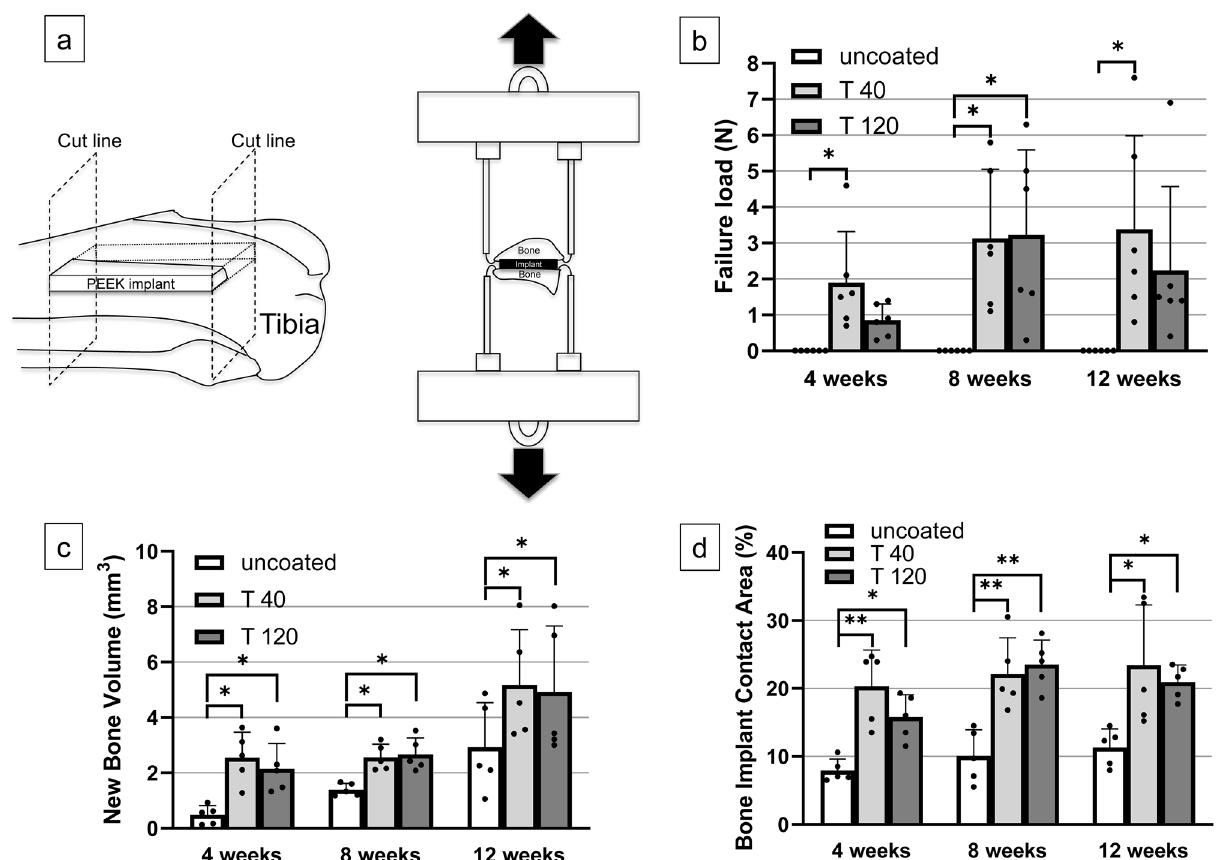
Figure 2. Results of the in vivo analyses of the rabbit tibia: ( a ) scheme of the detaching test measurements. The PEEK plates were implanted into the rabbit tibia and the bone-implant bonding strength was measured after harvesting; ( b ) failure load results for each study period; ( c ) new bone formation volume surrounding the PEEK implants according to the three-dimensional μCT analysis; ( d ) bone-implant contact ratio during the histological analysis (** p < 0.01, * p <